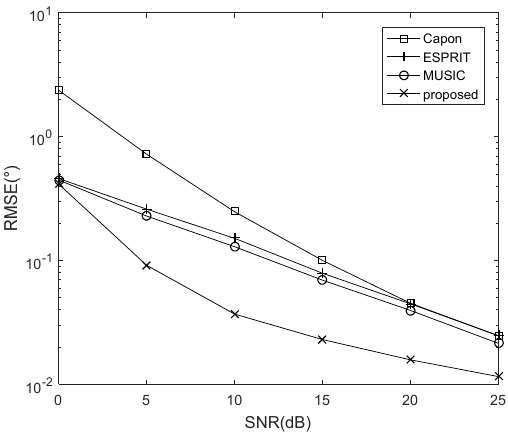
Figure 12. RMSE performance of different algorithms versus SNR.